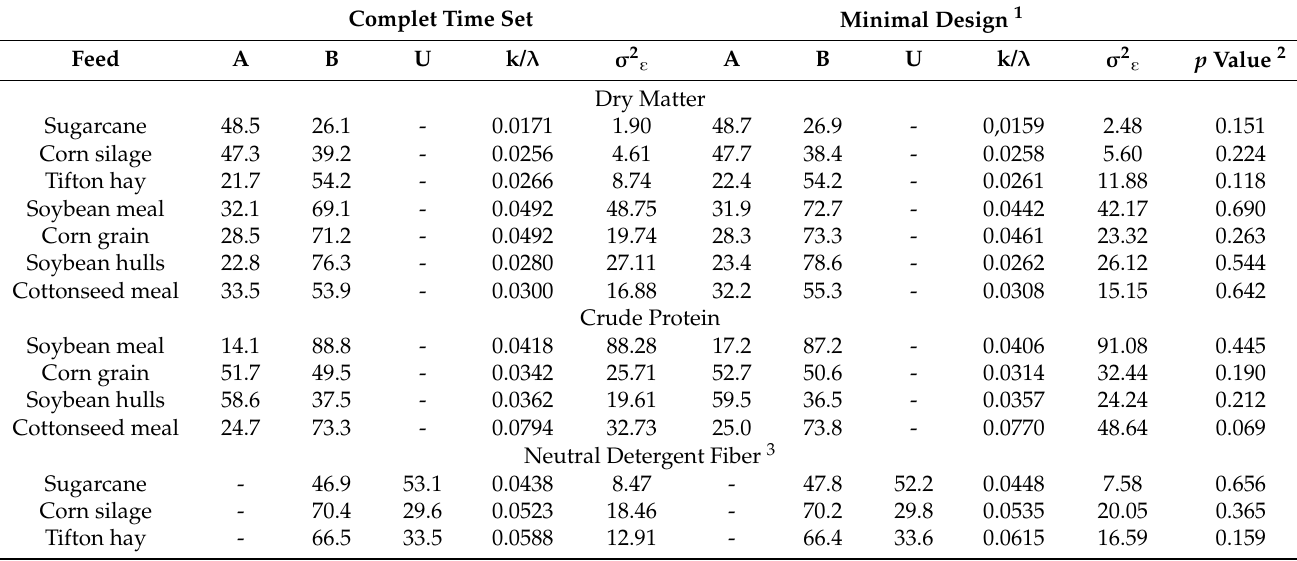
Table 6. Estimates of the degradation parameters of the dry matter, crude protein, and neutral detergent fiber of the different feeds considering the complete set of incubation times and the minimum designs of sampling